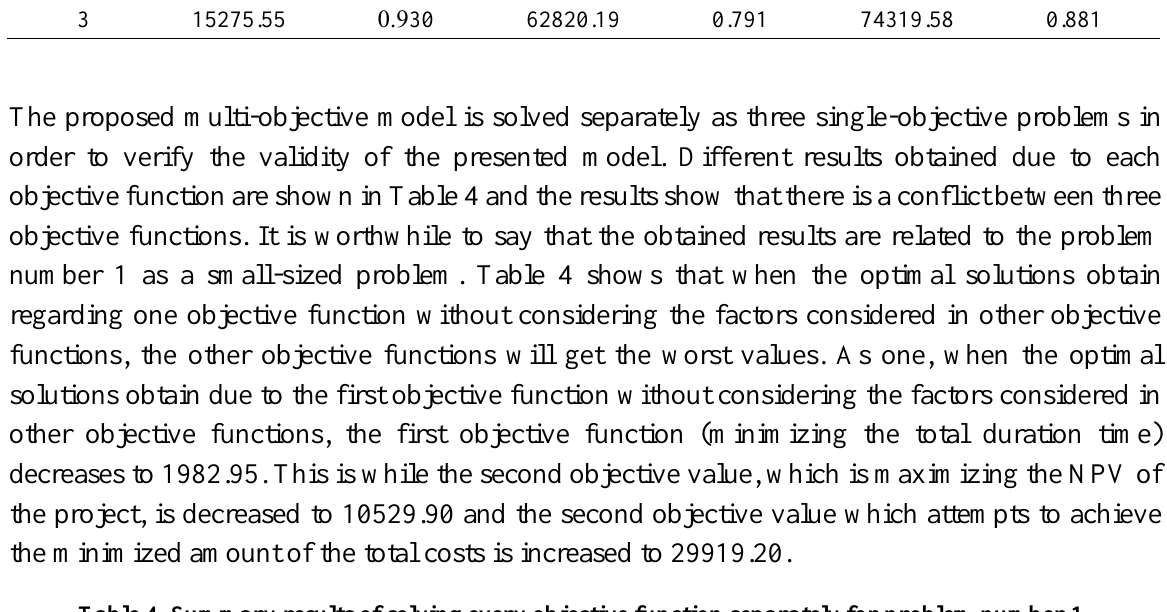
Table 4. Summary results of solving every objective function separately for problem number 1 . Objective